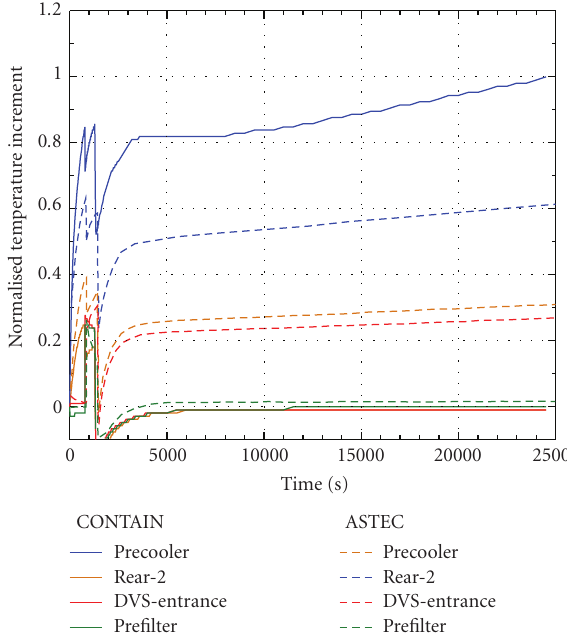
Figure 10: Temperature evolution in the main confinement compartments for the SB sequence (long term